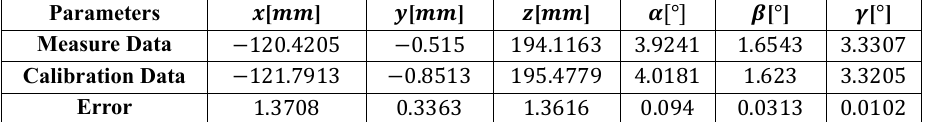
Table 1. Comparison of measurement data and calibration